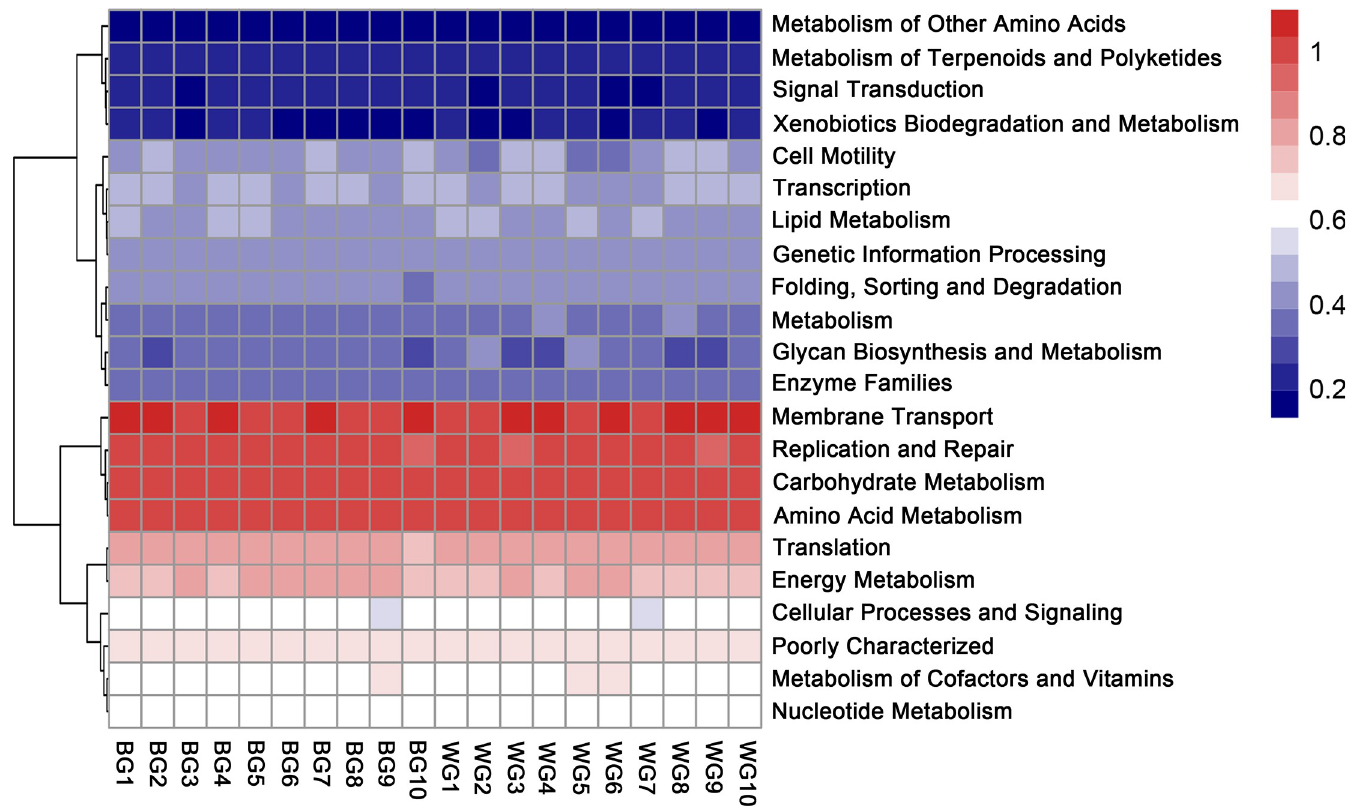
Fig 6. The main secondary metabolic pathways between BG and